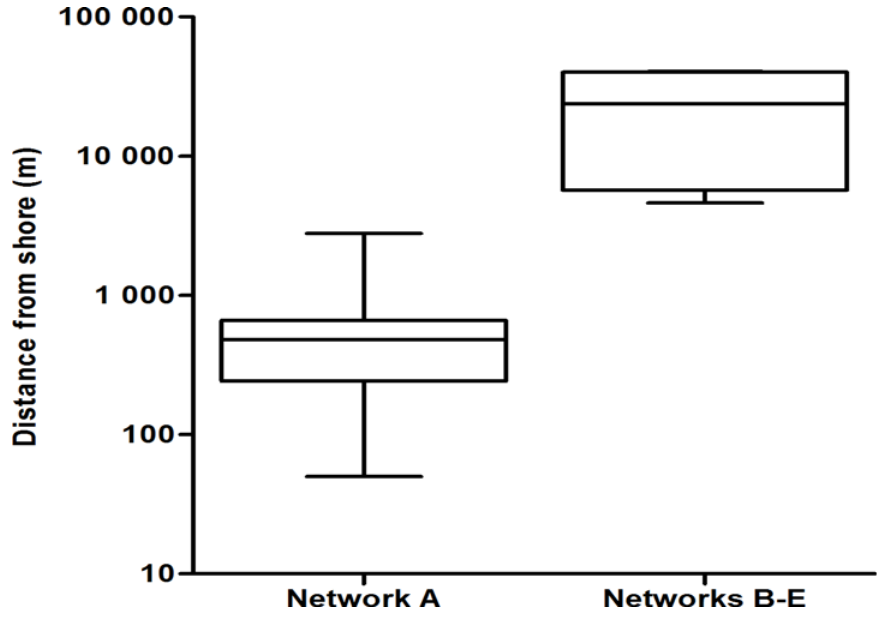
Fig 5. Distance from shore. The distance from shore for bottlenose dolphin groups that comprised network A (left) and networks B-E (right). The boxplot displays the mean and the 1 st and 3 rd quartile of the distance from shore. Whiskers indicate one standard deviation from the mean. Note the logarithmic scale of the